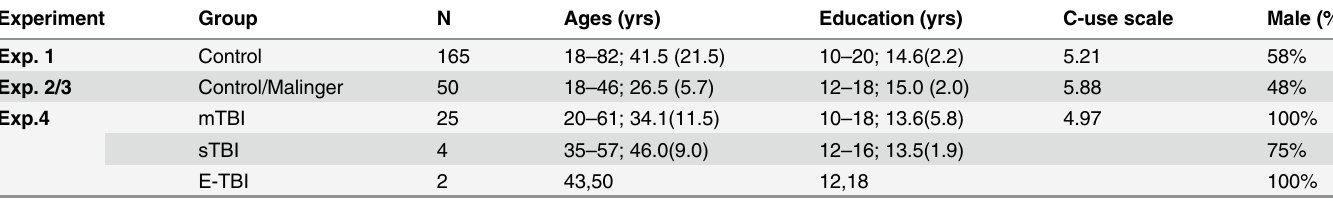
Table 2. Participant